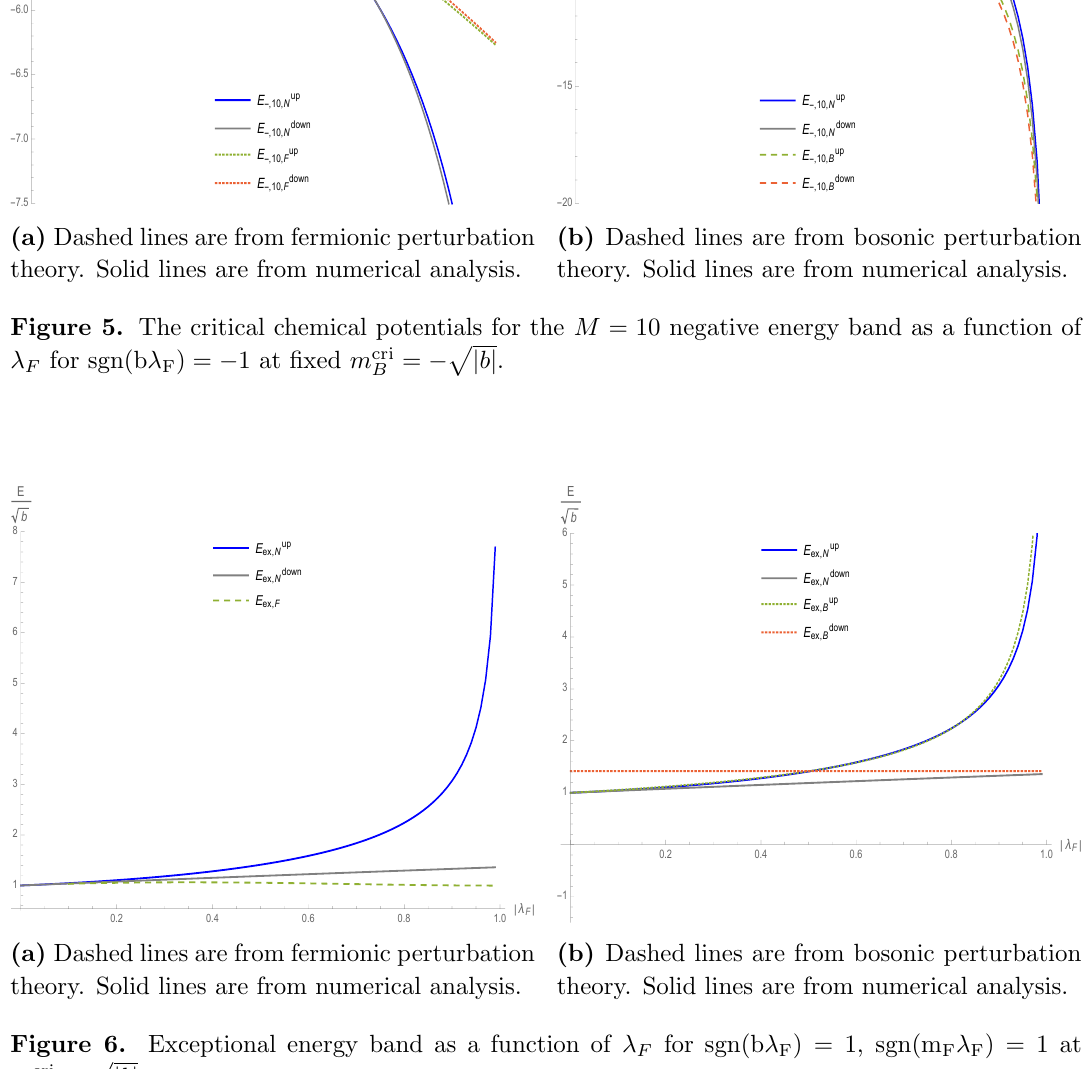
(b) Dashed lines are from bosonic perturbation theory. Solid lines are from numerical analysis.